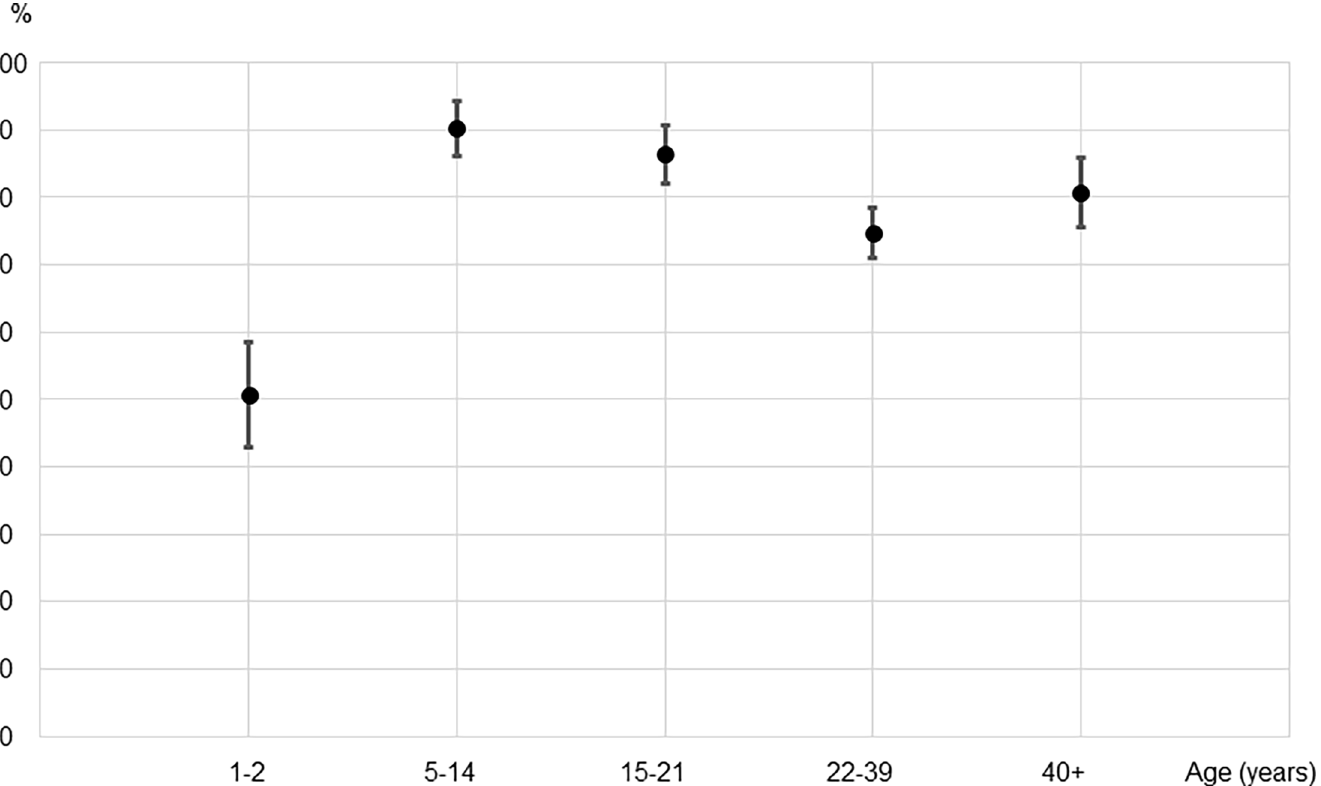
Fig 2. Rubella IgG seroprevalence measured by ELISA in different age groups from representative populations in Lao PDR, 2014. (cid:3) An ELISA value of 10 IU/ml was considered positive. †Individuals 5 to 14 years old and 15 to 21 years old were among the targeted age groups of supplementary immunization activities conducted in 2011 using the MR combination vaccine with coverage of 97%. Their IgG prevalence was estimated to be 88.2% (95%CI: